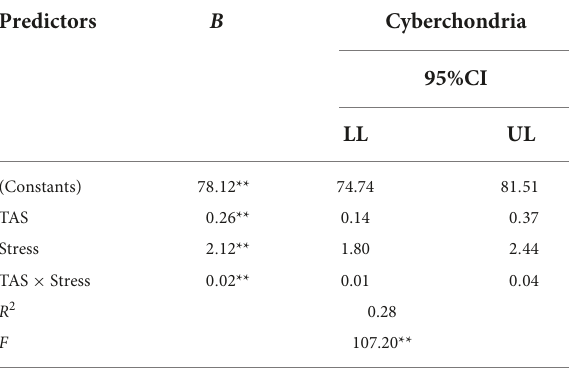
TABLE 5 Moderation of alexithymia between stress and cyberchondria.